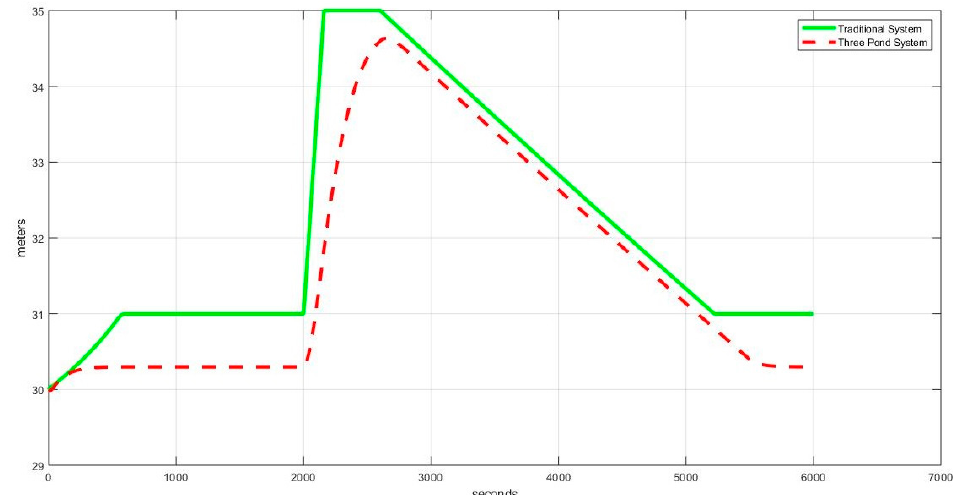
Figure 29. Comparison between the traditional system and the proposed system (half) (positive surge).